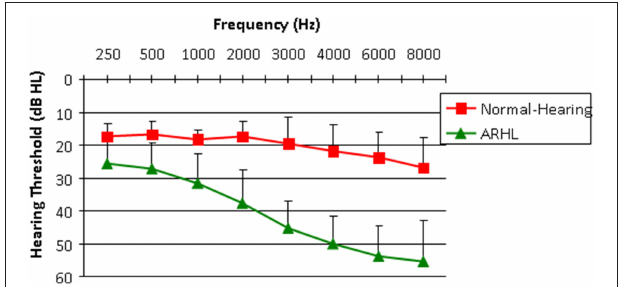
FIGURE 1 | Audiogram. Mean air conduction hearing thresholds across ears and participants are plotted for all Normal-Hearing (NH) and Age-Related Hearing Loss (ARHL) participants. Error bars represent standard deviations